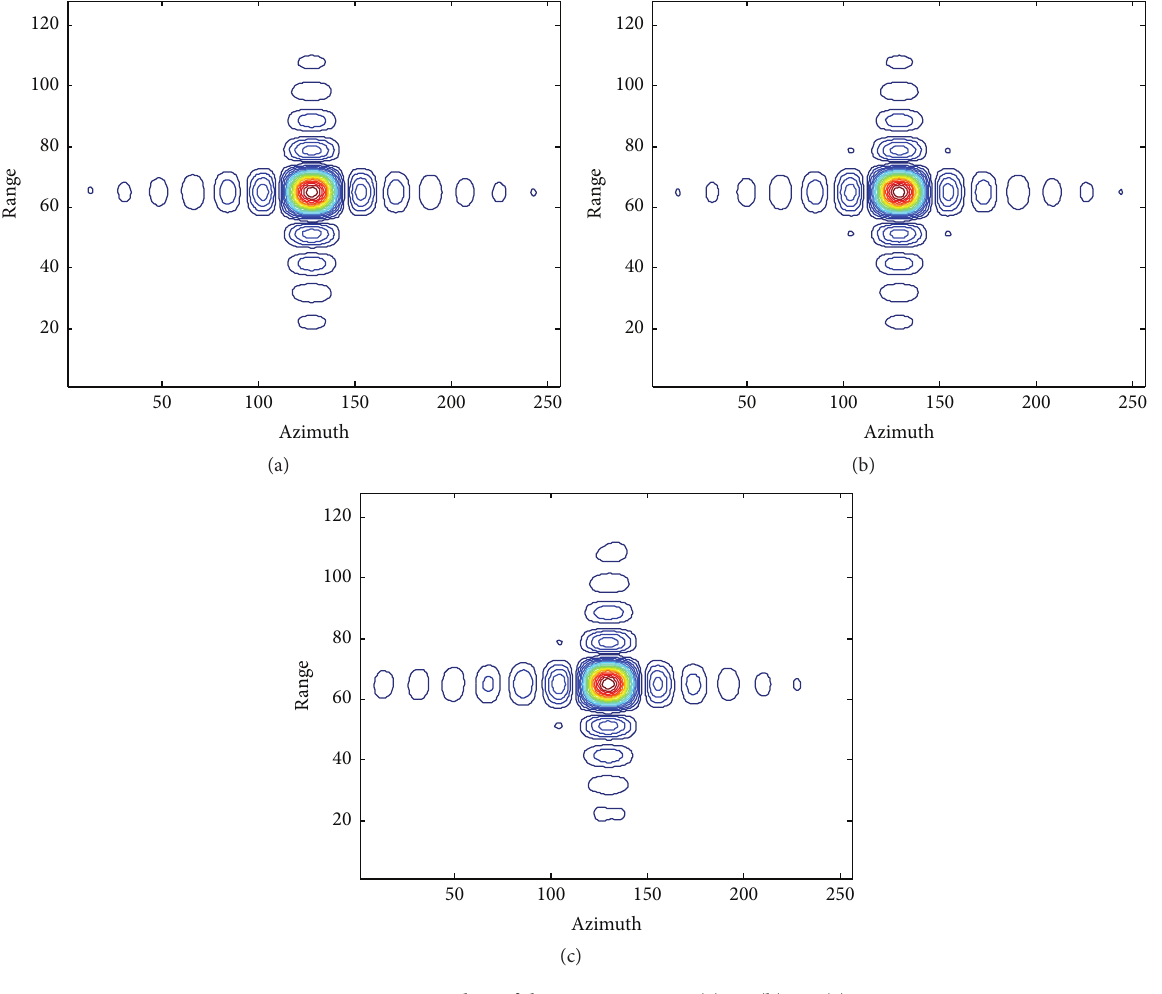
Figure 10: Contour plots of three point targets. (a) P1. (b) P2. (c)